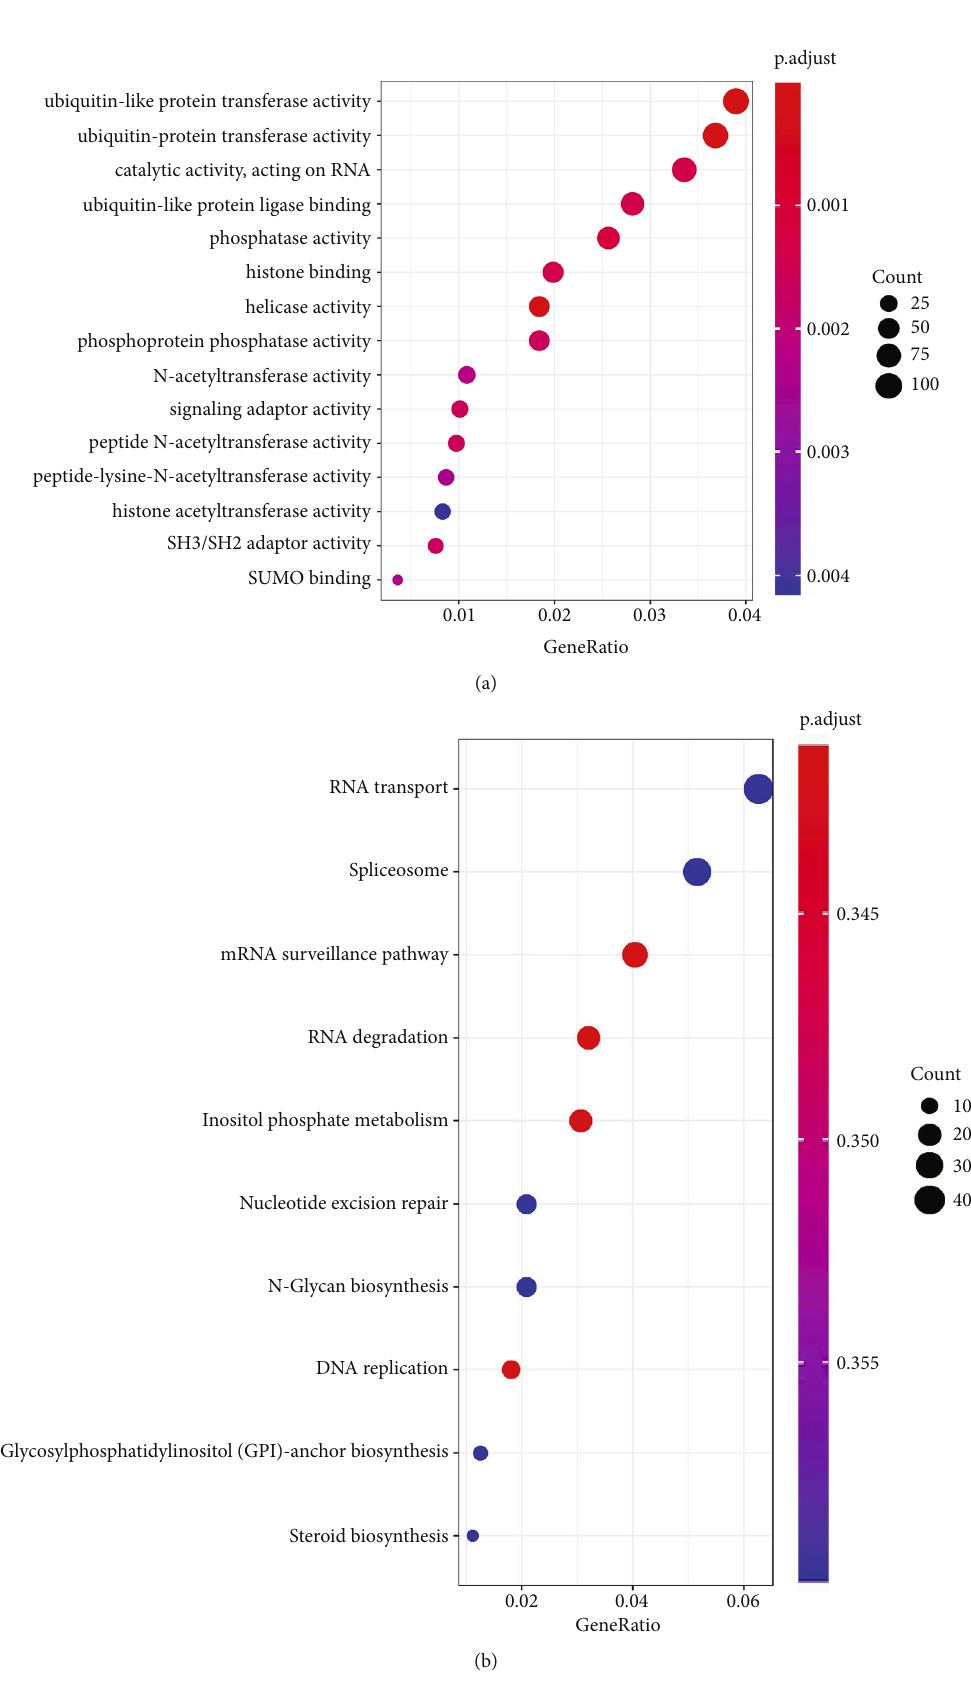
Figure 3: GO and KEGG pathway enrichment analyses of DEGs. (a) Top 15 GO enrichment analysis. (b) Top 10 pathways enrichment